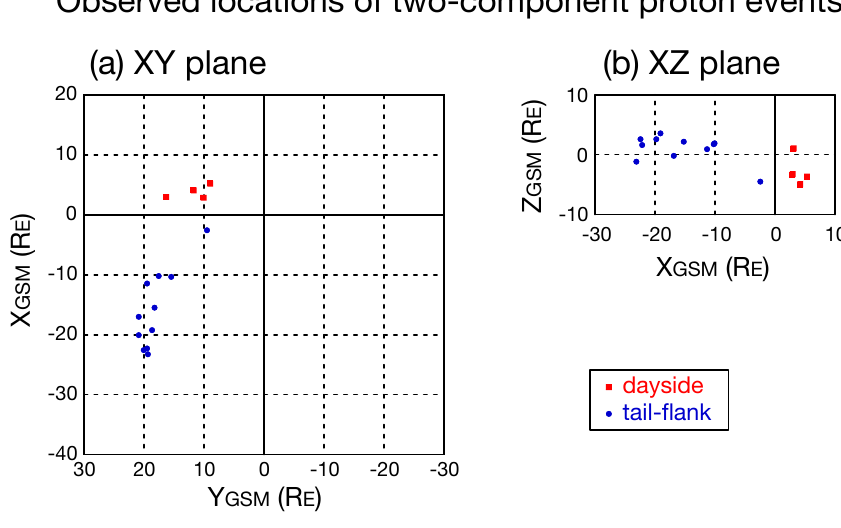
Fig. 8. Observed locations of the plasma sheet with the two-component protons near the dusk low-latitude boundary. Projections onto (a) the GSM XY plane and (b) the GSM XZ plane are shown. Dayside (tail) events are plotted as red squares (blue circles).